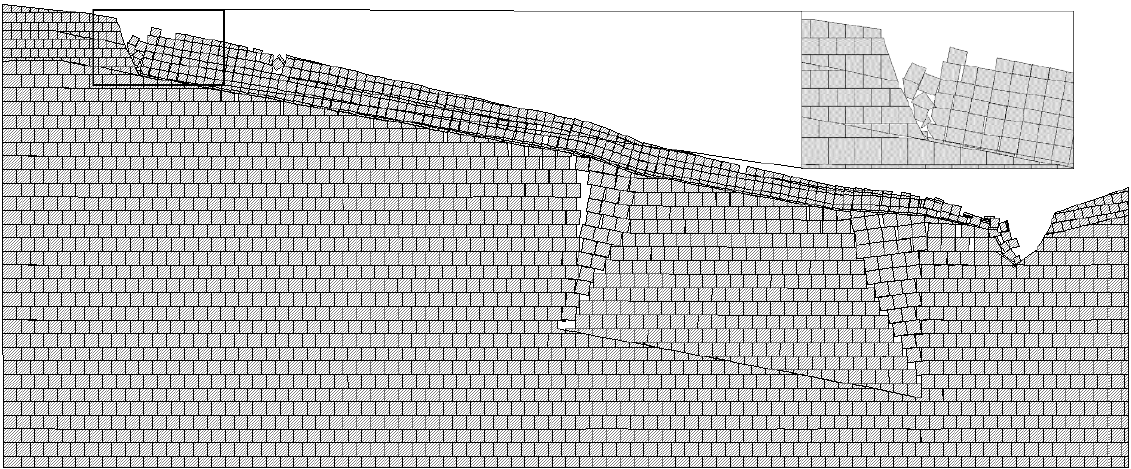
Figure 8. Iterative 300,000-step numerical simulation results.